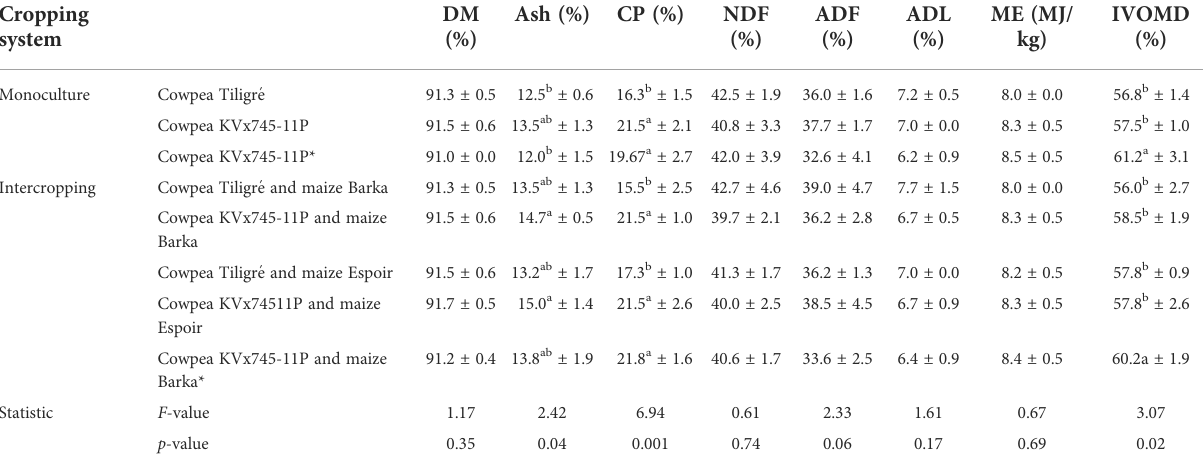
TABLE 9 Nutritive value of cowpea haulms according to cropping systems: on-station and on-farm. Cropping